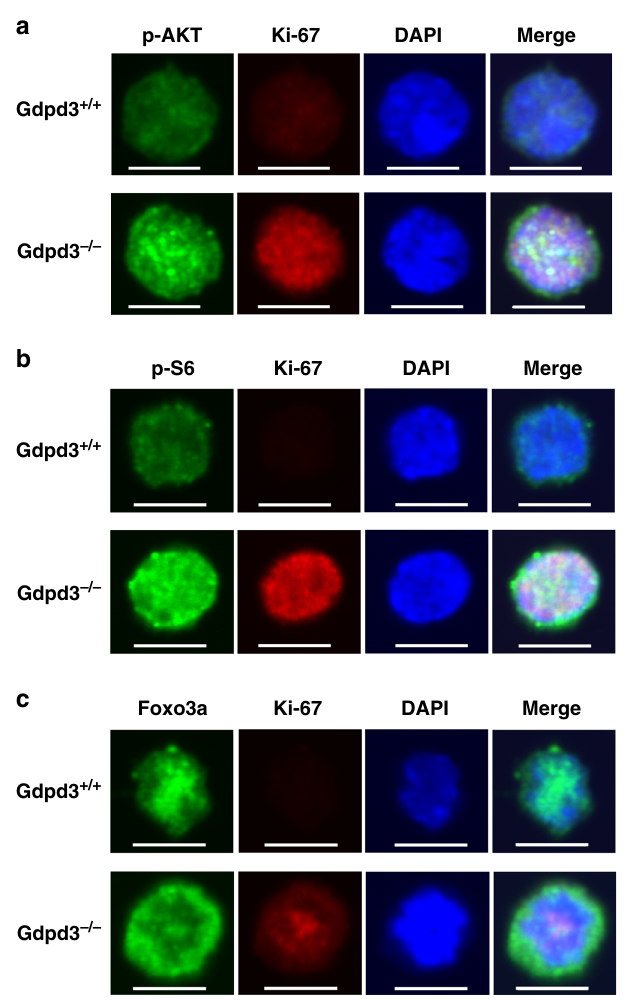
Fig. 5 Gdpd3 de fi ciency activates the AKT/mTORC1 pathway and suppresses Foxo3a in LT-CML stem cells in vivo. Phosphorylation of a AKT and b S6 ribosomal protein, and c nuclear localisation of Foxo3a in LT- CML stem cells that were isolated from Gdpd3 + / + tet-CML-affected mice (four males), or Gdpd3 − / − tet-CML-affected mice (three males), at 5 weeks post-Dox withdrawal. Cells were immunostained with mAbs to detect phosphorylated AKT (Ser473), phosphorylated S6 ribosomal protein (Ser235/236), Foxo3a, and Ki-67. Nuclei were visualised using DAPI. Scale bar, 10 μ m. Results are representative of three biologically independent trials. (See also Supplementary Fig.